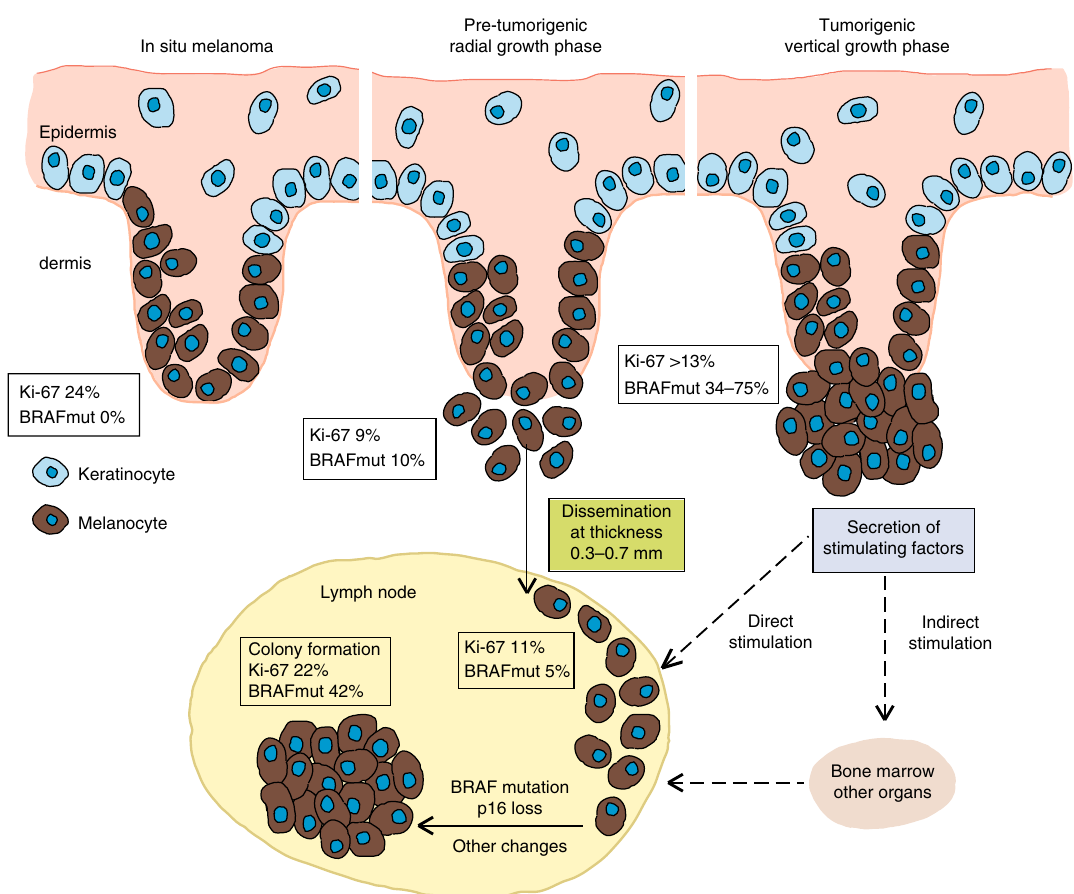
Fig. 9 Model of melanoma progression from local to metastatic disease. Histologic appearance, patient-derived dissemination estimate, proliferation rate and BRAF mutational state are integrated into the scheme. Data are taken from this study and from references 22, 30,